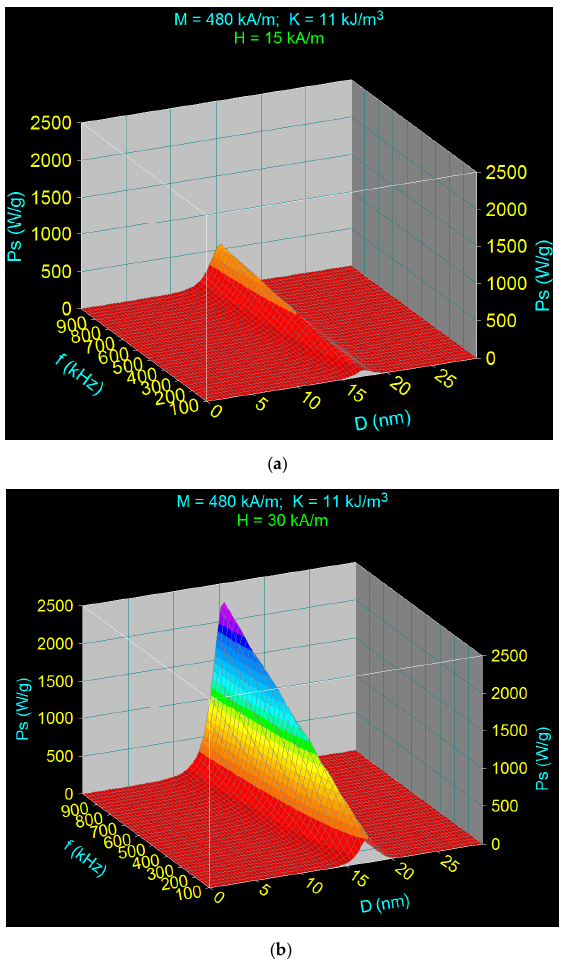
Figure 2. The specific loss power variation according to the Equation (17) depends on the nanoparticle diameter and the AMF frequency for the magnetic field amplitude of ( a ) 15 kA/m and ( b ) 30 kA/m.